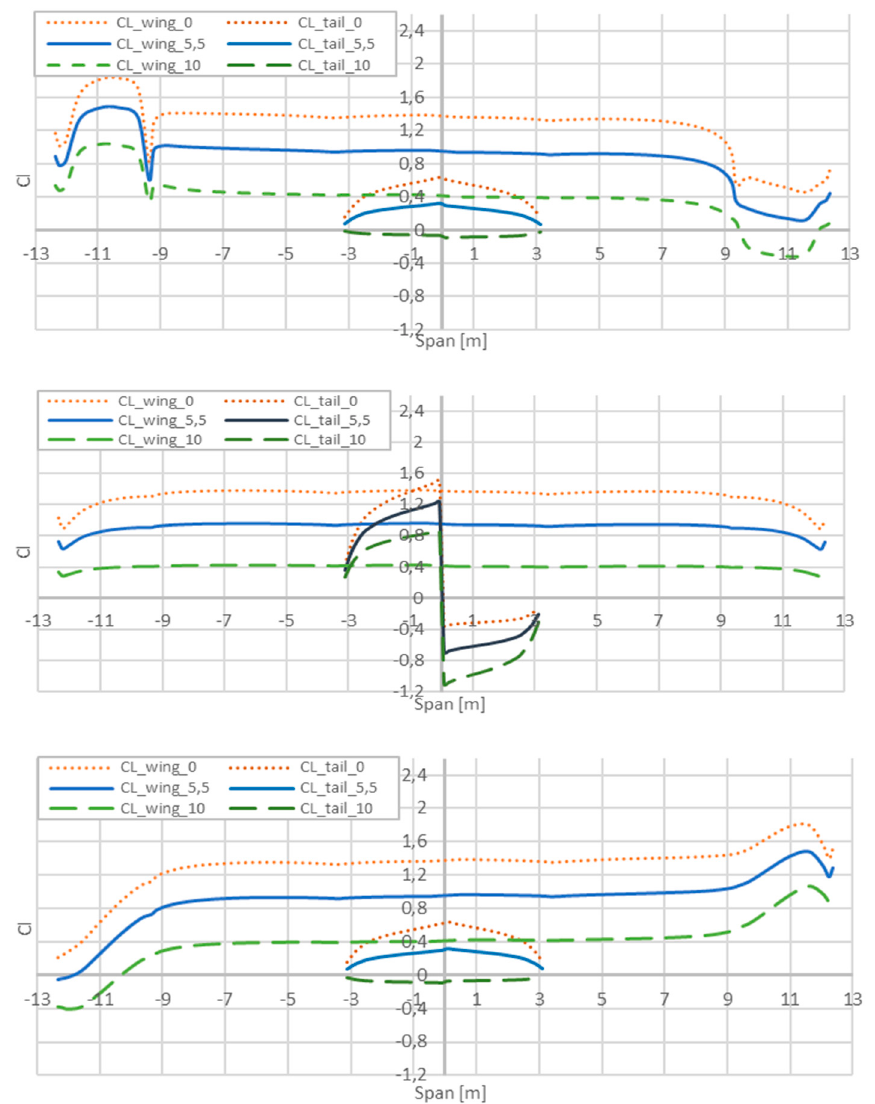
Figure 24. TWIN STRATOS UAV comparative analysis of roll operation for different steering ar- rangements. From above: ailerons, tail compliant trailing edge, wingtip twist morphing.